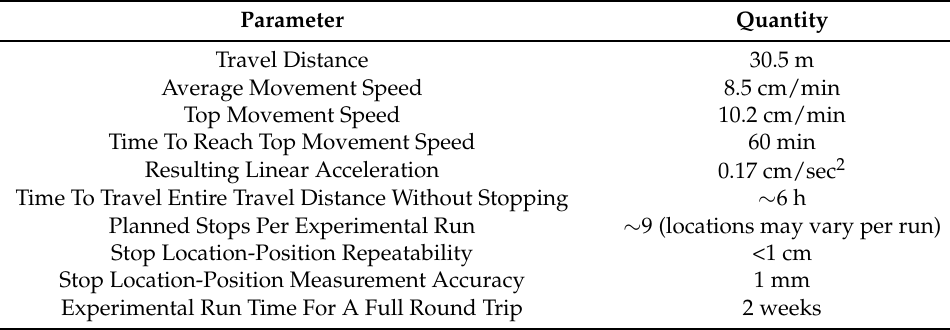
Table 26. Strawman PRISM movement profile for an experimental off-axis run.